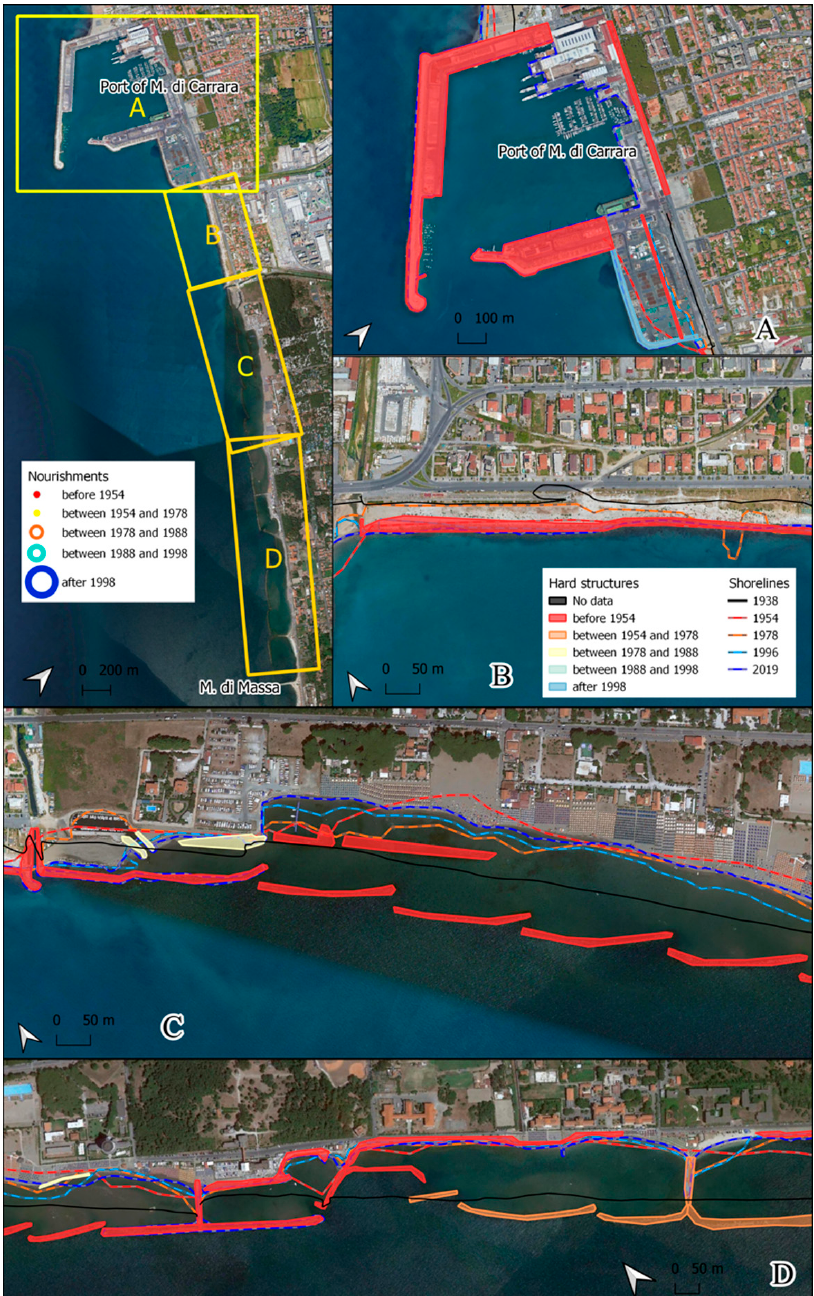
Figure 3. Identification of hard and soft operations along the sector comprised between the Port of Marina di Carrara and Marina di Massa. Polygons represent the hard structures; dots represent the nourishments. The yellow frames in the top left panel correspond to the zoom in panels to the right and at the bottom. The background image has been retrieved from the Google Earth data-base.